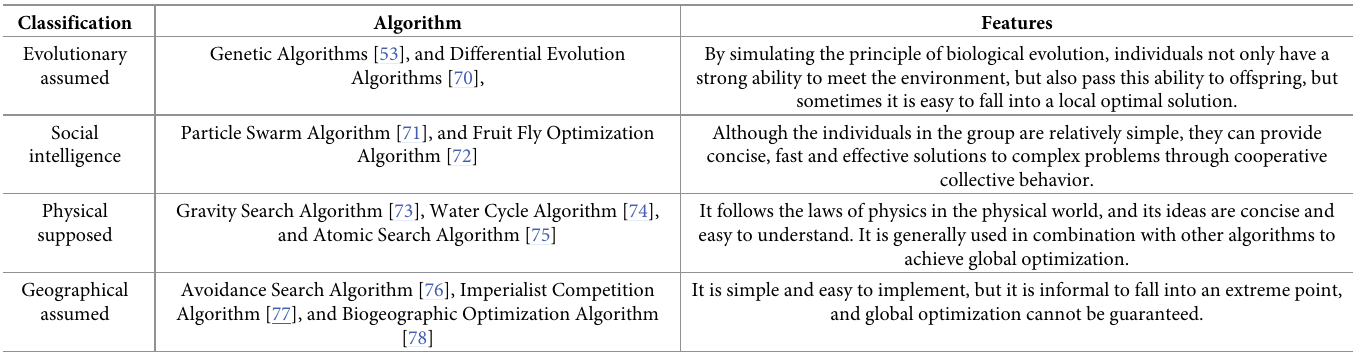
Table 3. Types and characteristics of optimization algorithms.